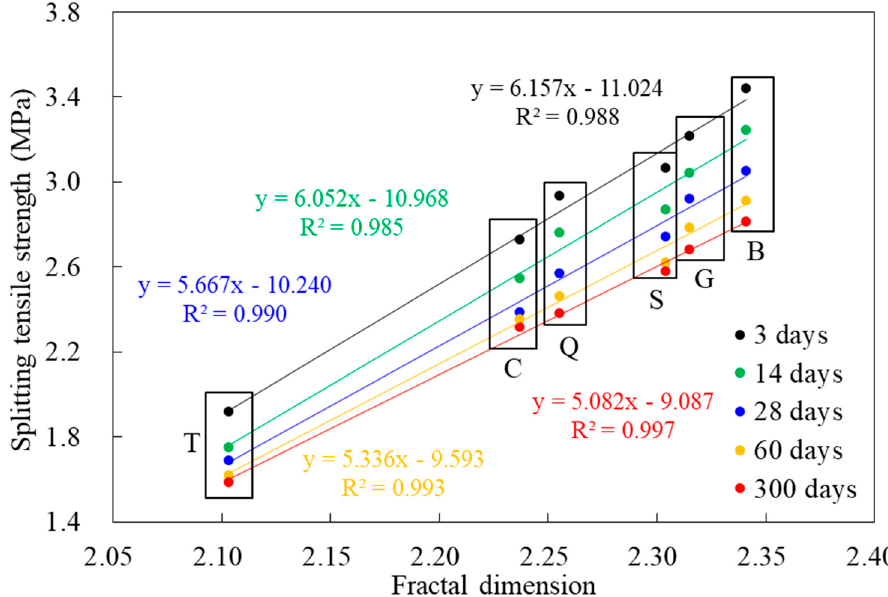
Figure 6. The variation law of splitting tensile strength with fractal dimension value D.